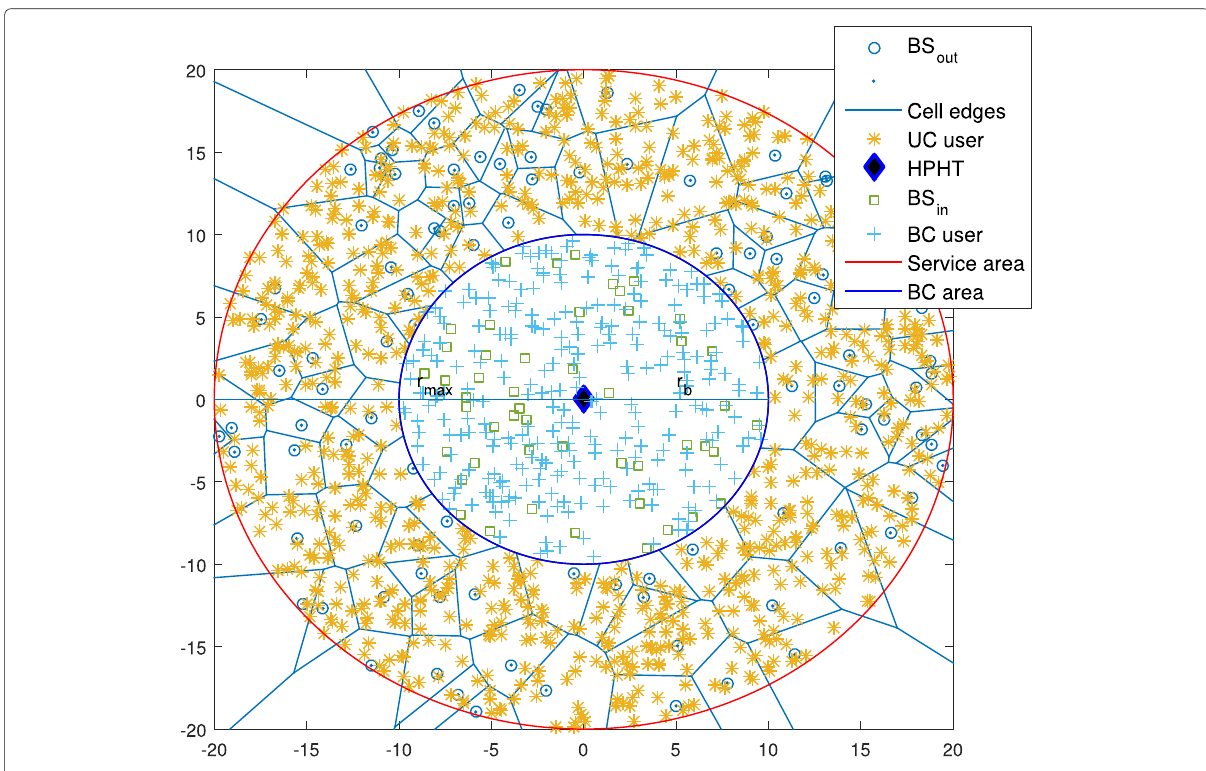
Fig. 1 An example of a service area, with 20 km radius, and 10 km broadcast